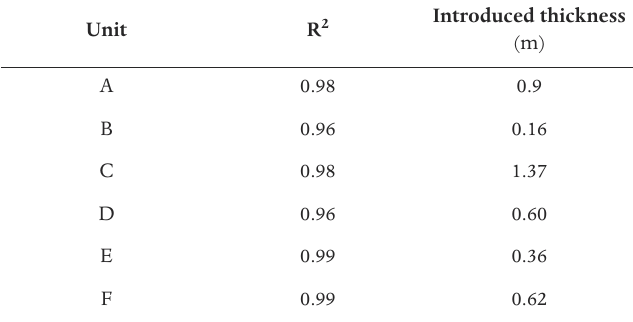
Table 1. Correlation index (R 2 ) of the curves/ straight lines plotted in Figure 4. The introduced thickness indicates the value extrapolated from the curves or the straight lines at 1 km from the